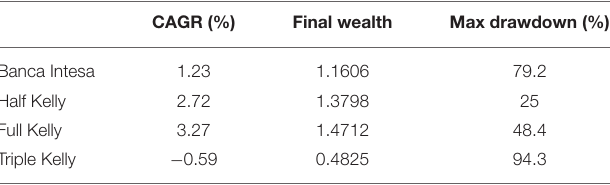
TABLE 7 | Composition of the Optimal Full Kelly Portfolio for in-sample (monthly) data.